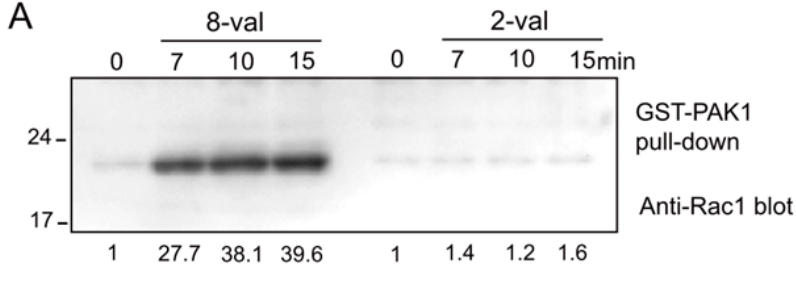
Figure 4. Activation of Rac1 by 8-val-TatP exposure linked to slowerig diffusion and